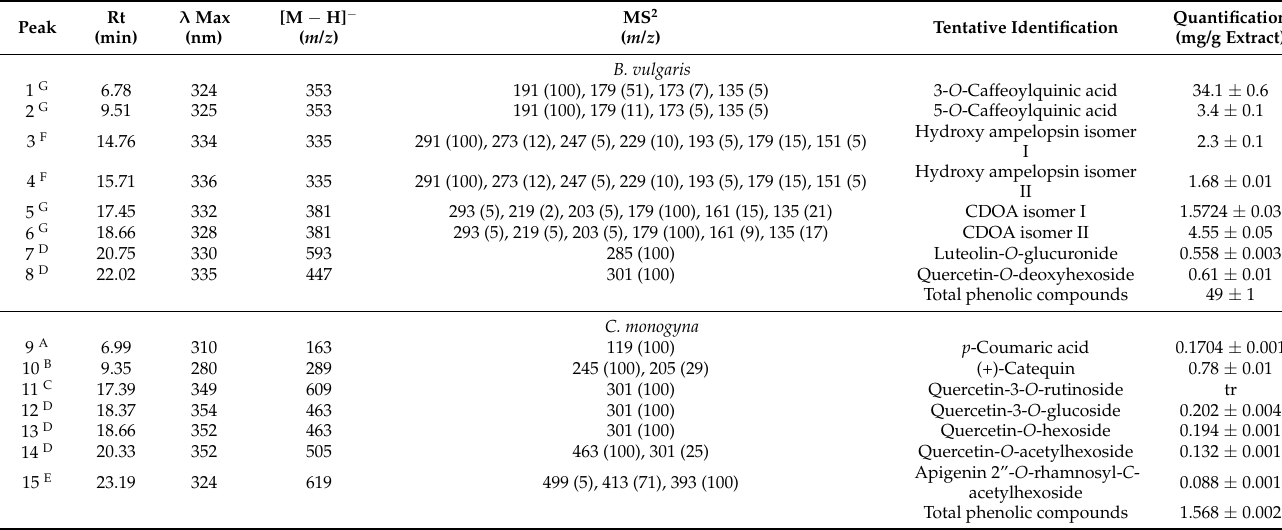
Table 1. The retention time (Rt), wavelengths of maximum absorption ( λ max ), tentative identification, mass spectral data, and quantification of phenolic compounds identified in the extracts of B. vulgaris and C. monogyna (Mean ± SD).